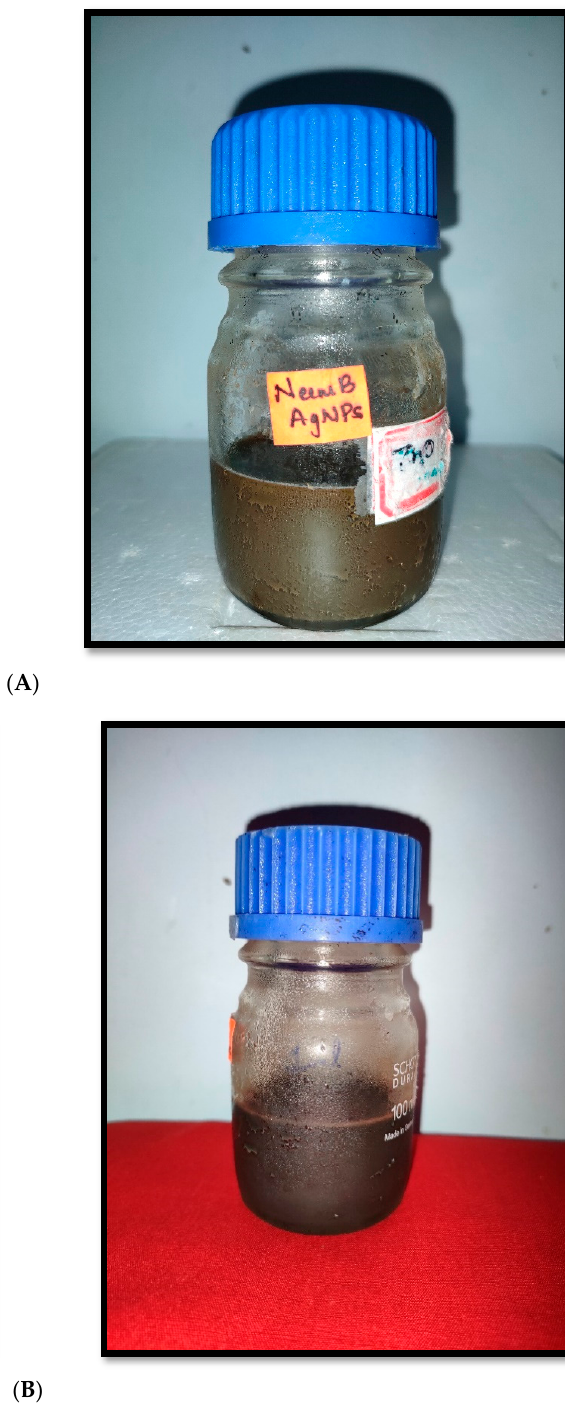
( B ) Figure 2. ( A ) UV visible spectroscopic image of Azadirachta indica -based silver nanoparticles. ( B ) UV visible spectroscopic image of Pongamia pinnata -based silver nanoparticles.